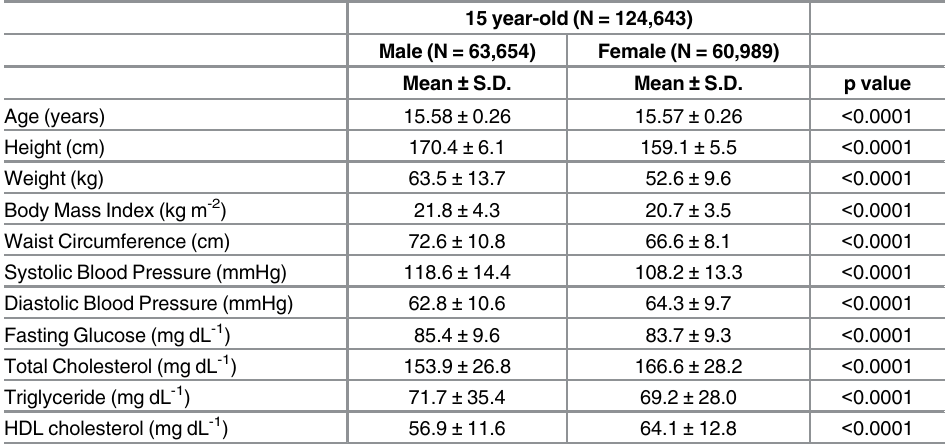
Table 1. Characteristics of participants.